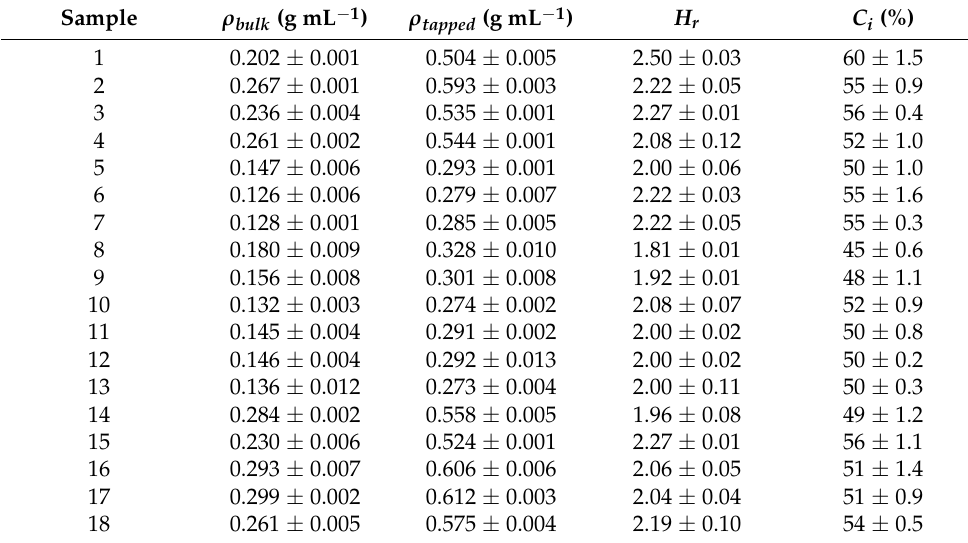
Table 2. Results of the apparent bulk density ( ρ bulk ), apparent tapped density ( ρ tapped ), Hausner ratio ( H r ) and compressibility index ( C i ) of spray-dried samples under different conditions according to the factorial